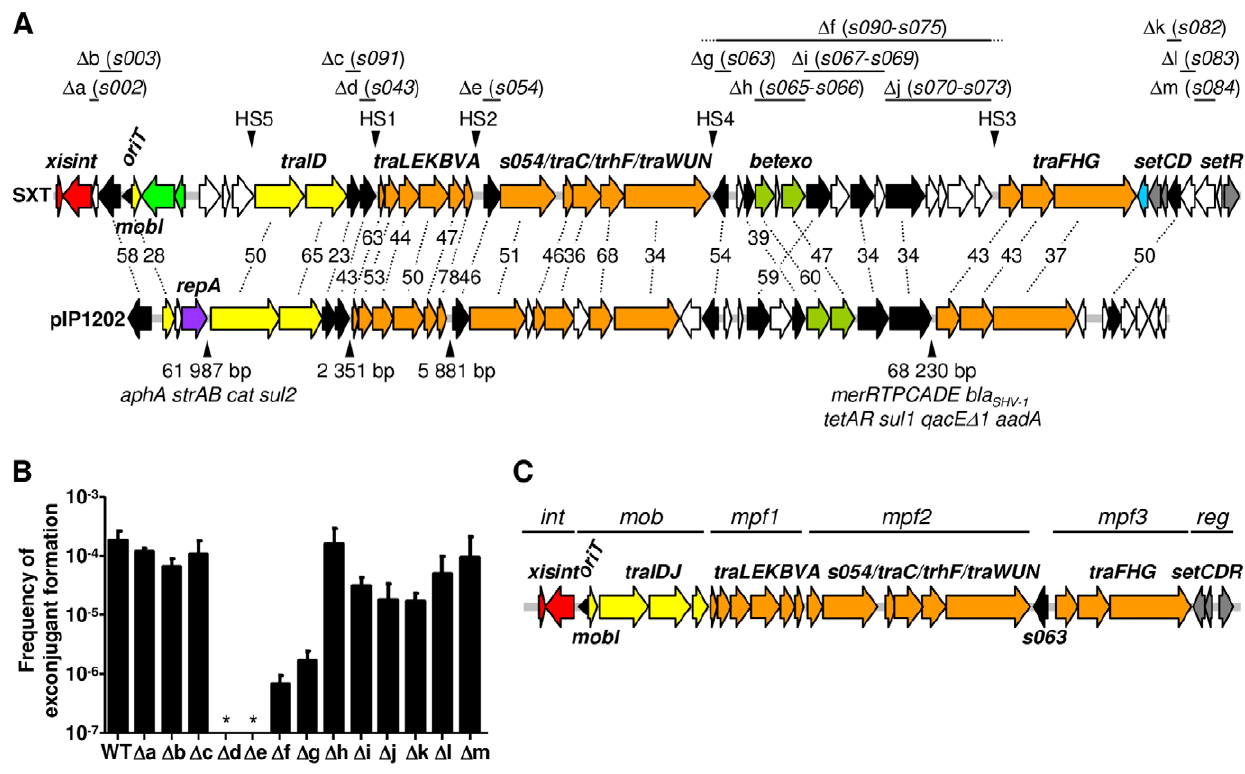
Figure 4. Comparison of the SXT/R391 core genome with the genome of pIP1202 and defining the minimal functional SXT/R391 gene set. (A) Alignment of the conserved core genes of SXT/R391 ICEs with the genome of the IncA/C conjugative plasmid pIP1202 from Yersinia pestis . The top line shows the same core ICE genes shown in Figure 2A. ORFs are color coded as follows: DNA processing, yellow; mating pair formation, orange; DNA recombination and repair, green; integration/excision, red; replication, purple; regulation, gray; entry exclusion, blue; homologous genes of unknown function, black; genes without corresponding counterparts in ICEs and pIP1202, white. Numbers shown in the middle represent % identity between the orthologous proteins encoded by SXT and pIP1202 [GenBank:NC_009141]. The positions of the hotspots in SXT/R391 ICEs are marked by downward pointing arrowheads. For pIP1202, the size of the sequences (which include IncA/C backbone DNA as well as variable DNA) found at these locations as well as resistance markers are indicated by upward pointing arrowheads. aphA , aadA and strAB confer resistance to aminoglycosides. sul1 and sul2 confer resistance to sulfonamides. cat , bla SHV-1 , tetAR , qacED1 and merRTPCADE confer resistance to chloramphenicol, b -lactams, tetracyclines, quaternary ammonium compounds and mercury ions, respectively. Detailed descriptions of the conserved backbone of the IncA/C conjugative plasmids have been published elsewhere [48,50]. Regions that were deleted from SXT to investigate the function of genes of unknown function (see panel B) are indicated with straight lines. Dotted lines indicate that the deletion included DNA in the adjacent hotspots. (B) Influence of deletion of genes of unknown function on the frequency of SXT transfer. The mean values and standard deviations from three independent experiments are shown. * indicates that the frequency of transfer was below the detection level ( , 10 2 8 ). Deletion mutants SXT D a, SXT D k and SXT D l, transferred at frequencies that were not significantly different from that of wild-type SXT (data not shown). (C) Proposed minimal set of genes necessary for a functional SXT/R391 ICE. int , integration/excision module; mob , DNA processing module; mpf , mating pair formation modules; reg , regulation module.